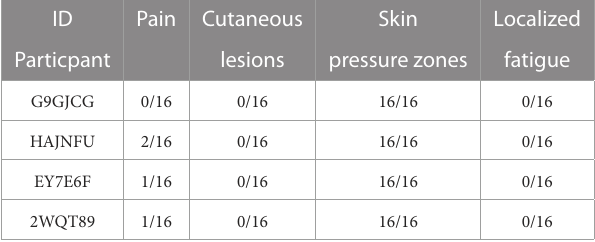
TABLE3 ResultsofthesafetytestafterusingtheRobHand:Presenceof